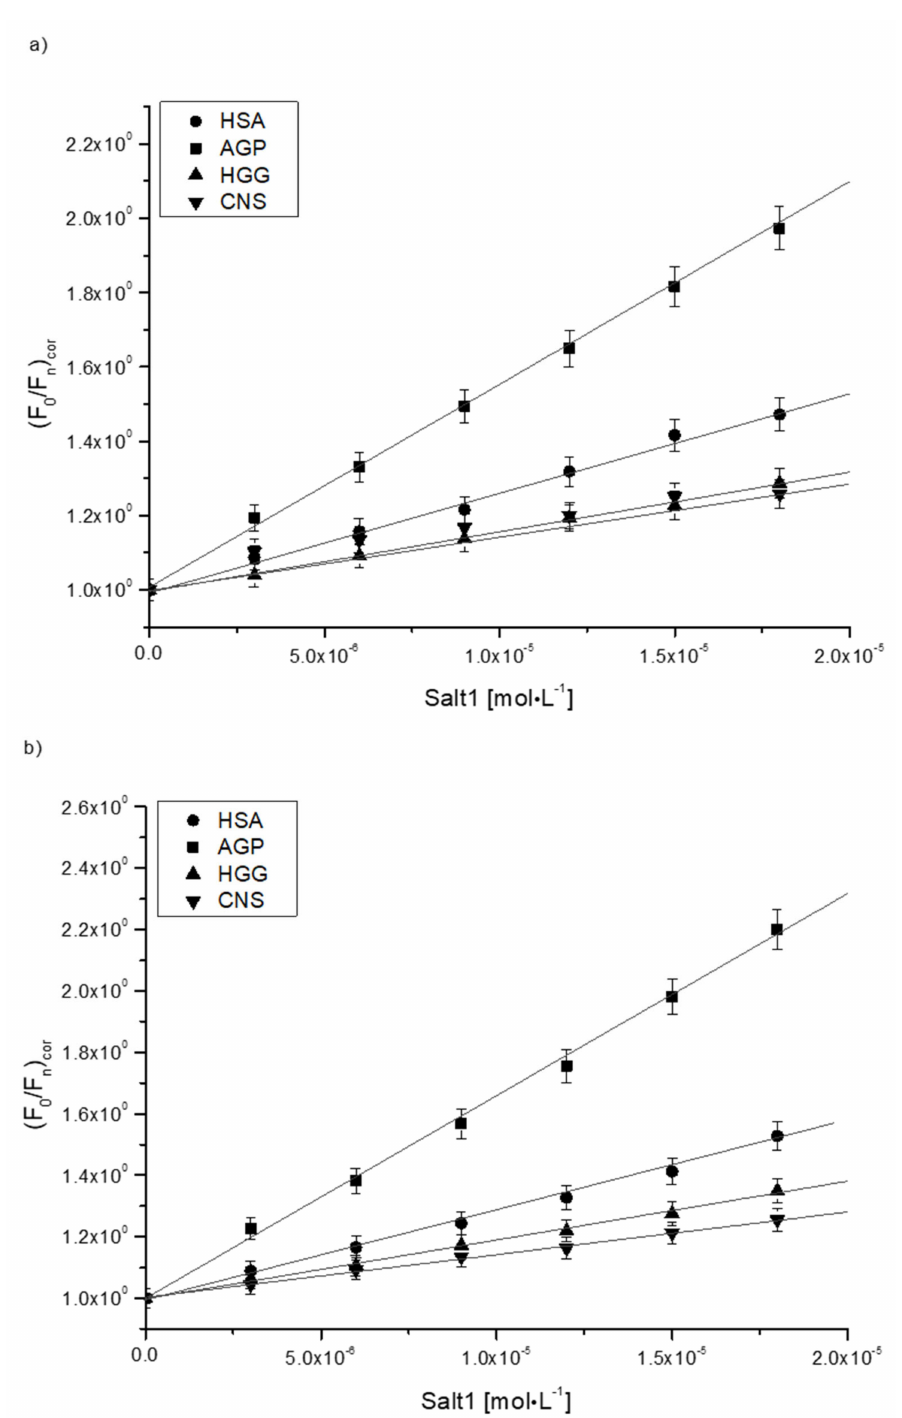
Figure 3. Stern–Volmer plots for the complexes of Salt1 with HSA, AGP, HGG and CNS at ( a ) λ ex 275 nm and ( b ) λ ex 295 nm. Based on the Stern–Volmer Equation (3) for the complexes of Salt1 with HSA, AGP, HGG and CNS, the Stern–Volmer constants (K S-V ) [M − 1 ] and bimolecular quenching rate constants (k q ) were determined and are presented in Table